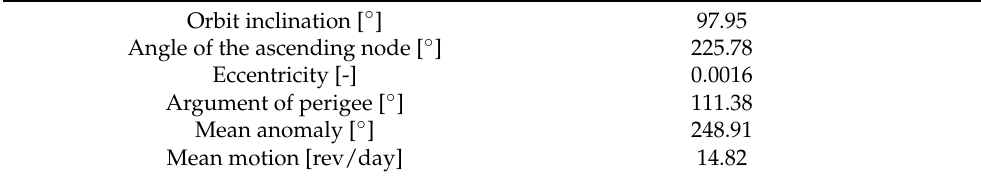
Table 3. Orbital